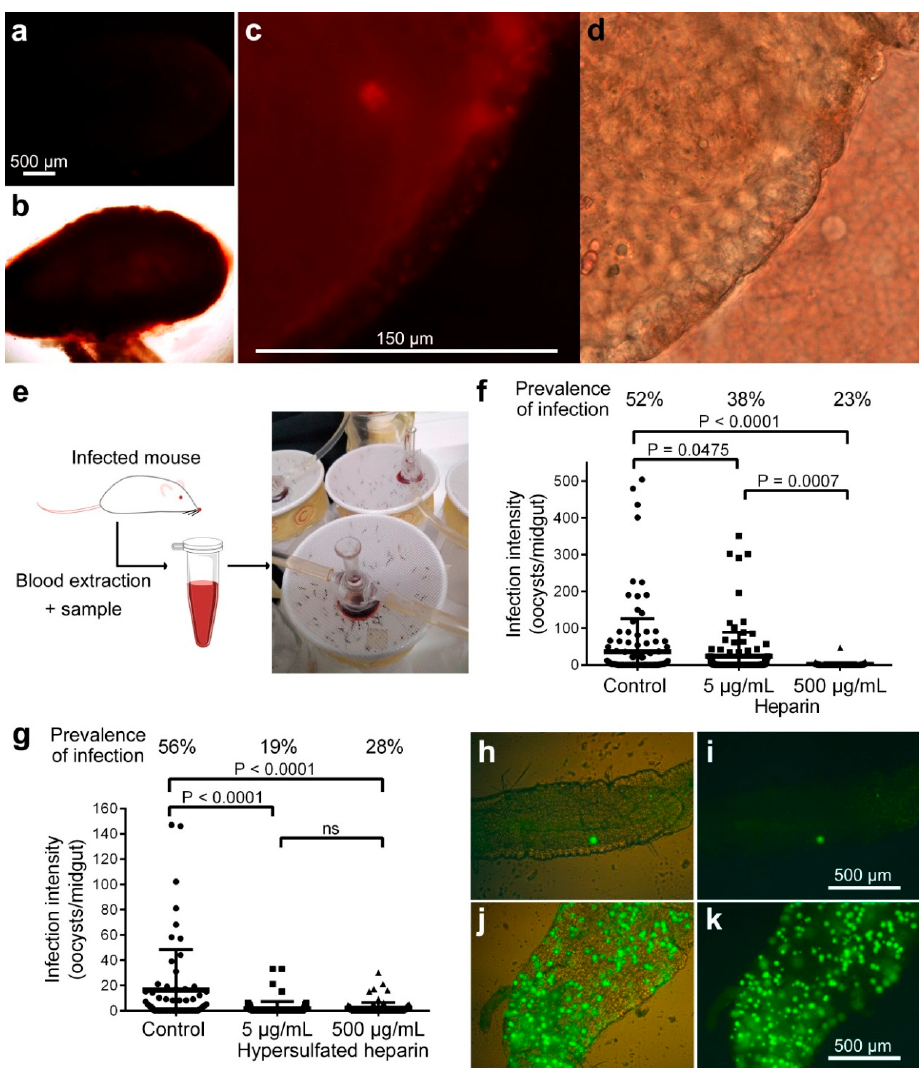
Figure 3. Effect on ookinete development of heparin fed to mosquitoes by membrane feeding assay (MFA). ( a – d ) Fluorescence detection of heparin-Cy5 fed to A. stephensi female mosquitoes by blood feed. ( a , b ) Whole dissected midgut and ( c , d ) magnification of the same midgut with the blood bolus